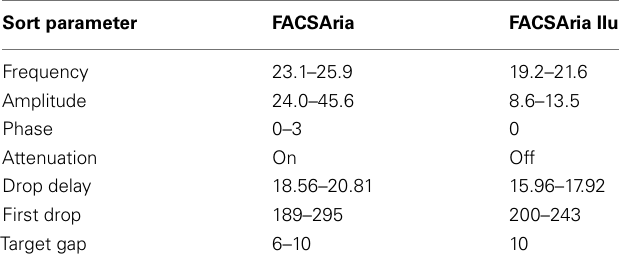
Table 1 |A sample range of low-pressure stromal sorting parameters for 100 μ m tip in the FACSAria and FACSAria IIu (BD Biosciences). n = 4–8 independent experiments.